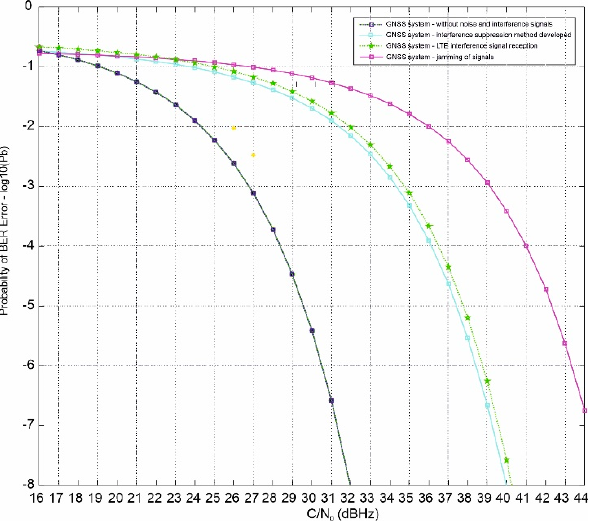
Figure 7. The course of the 𝐶 𝑁⁄ ratio for the GNSS system with the presence of LTE system inter- ference signals.